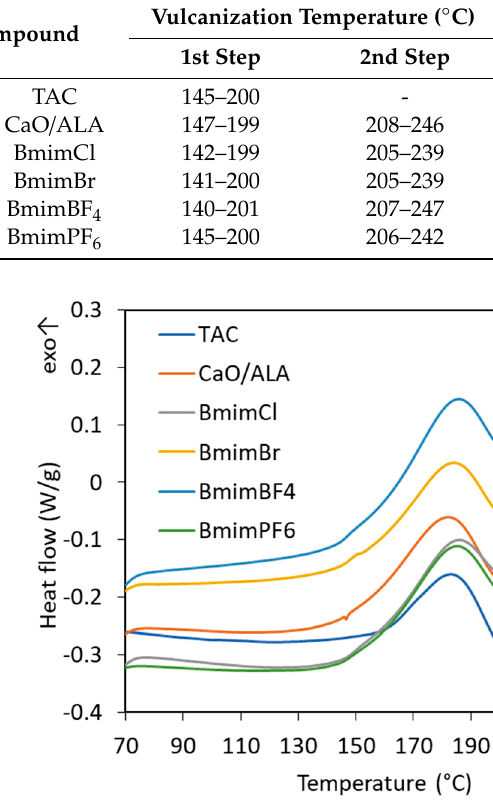
Figure 8. Differential scanning calorimetry (DSC) curves for the vulcanization of silica-filled EPM containing CaO/ALA and ILs.